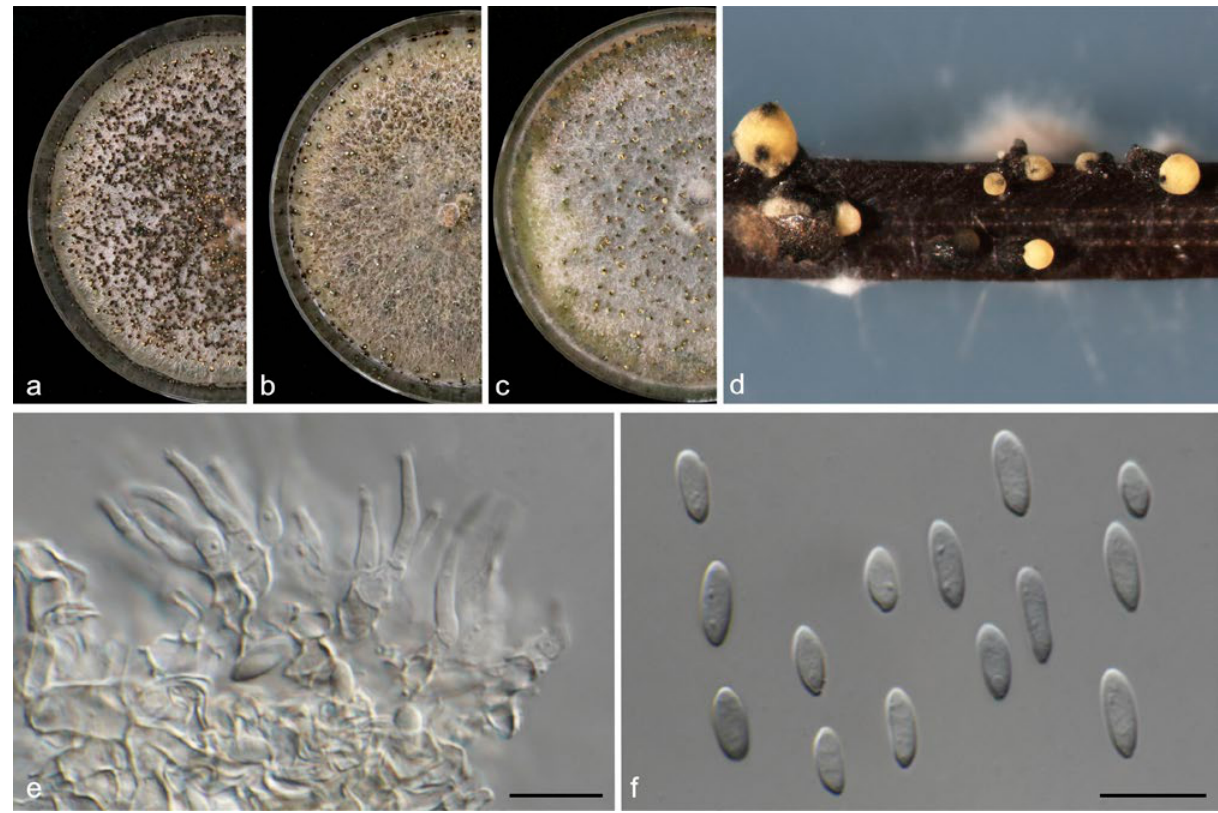
Figure 4. Diaporthe portugallica (CBS 144228). (a–c) Colonies after 7 d at 21°C on MEA, OA and PDA. (d) Conidiomata sporu - lating on PNA. (e) Conidiogenous cells. (f) Alpha conidia. Scale bars = 10 μ